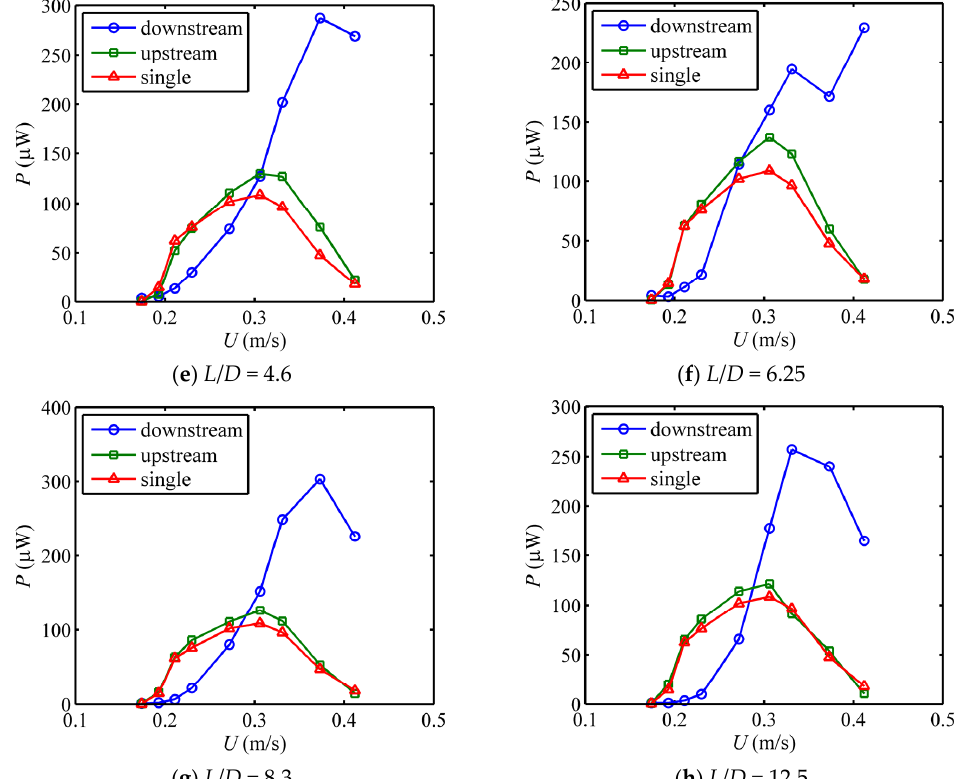
Figure 4. Output powers of two harvesters as a function of the water speed for eight spacing ratios: ( a ) L / D = 1.7; ( b ) L / D = 2.5; ( c ) L / D = 3.3; ( d ) L / D = 3.75; ( e ) L / D = 4.6; ( f ) L / D = 6.25; ( g ) L / D = 8.3; ( h ) L / D = 12.5.